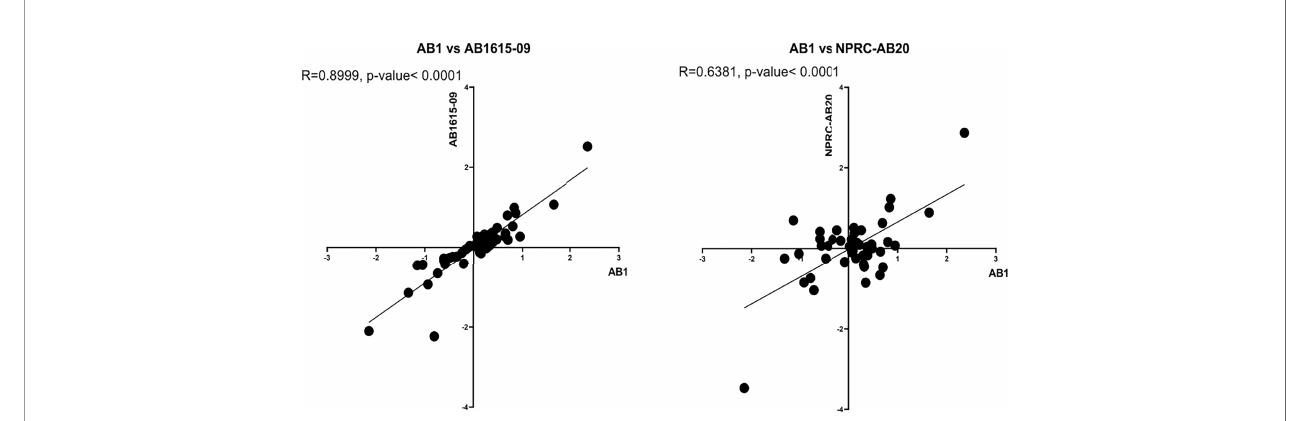
FIGURE 8 | Complement resistance gene transcription levels correlate between phenotypically similar A. baumannii clinical strains. The relative expression levels of 52 complement resistance genes was determined in the complement resistant strain, NPRC-AB20 and two intermediate susceptible strains, AB1 and AB1615-09. Correlation between fold changes in expression of the 52 genes between the AB1 and AB1615-09 strain (left panel) and AB1 and the NPRC-AB20 strain (right